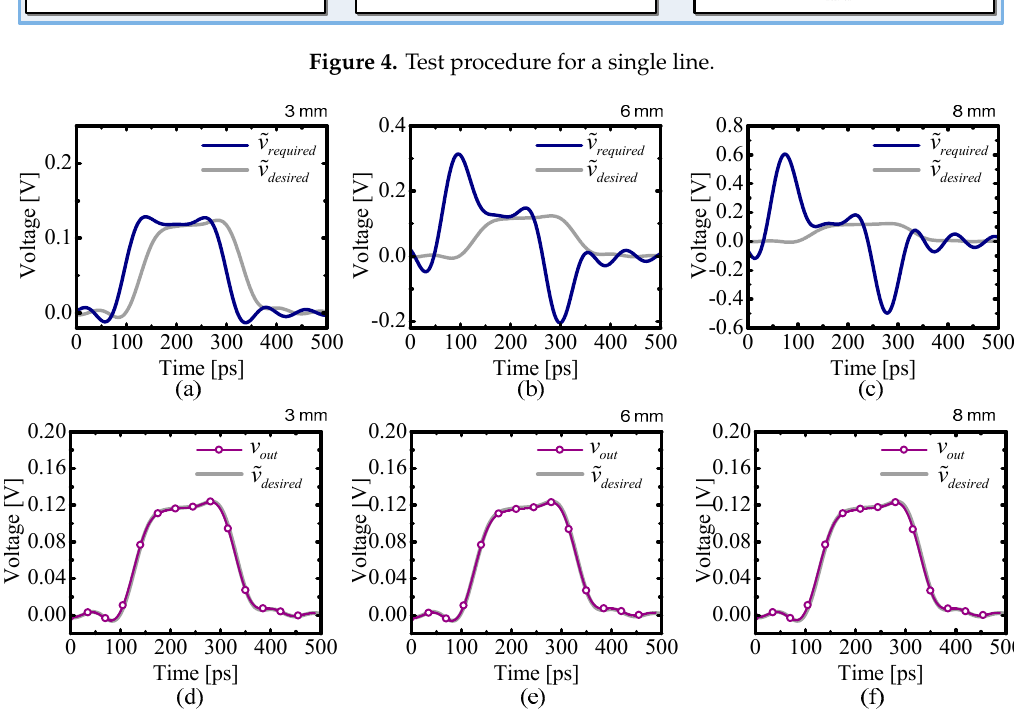
Figure 5. Proposed design results. ( a – c ) are Algorithm 1 results for 3 mm, 6 mm, and 8 mm length. ( d – f ) are SPICE verification results for 3 mm, 6 mm, and 8 mm lengths. Note that the frequency components exceeding 12.5 GHz were relaxed.